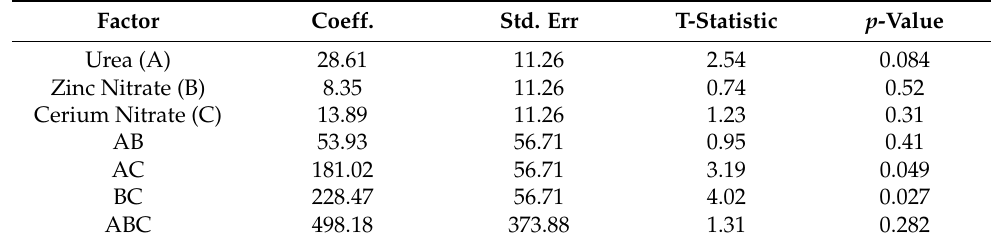
Table 6. Parameters of the Student’s test for the evaluation of the coefficients of the cubic model.